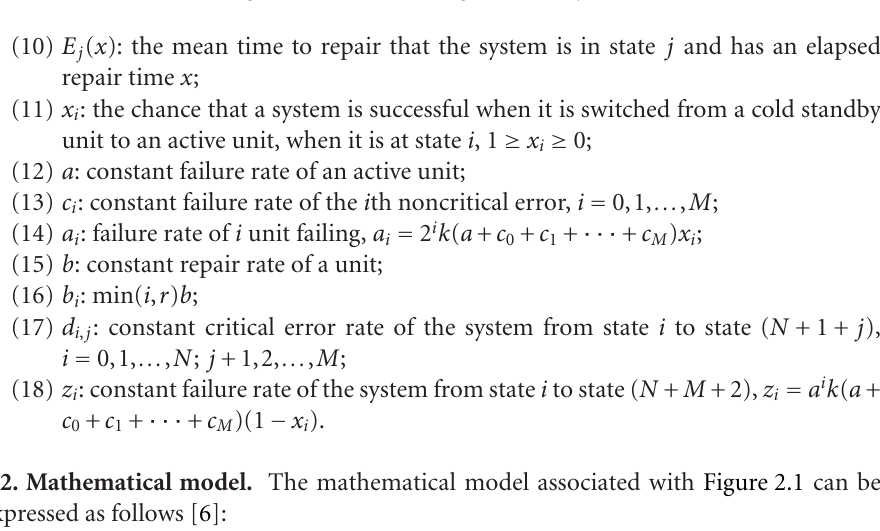
Figure 2.1. Transition diagram of the